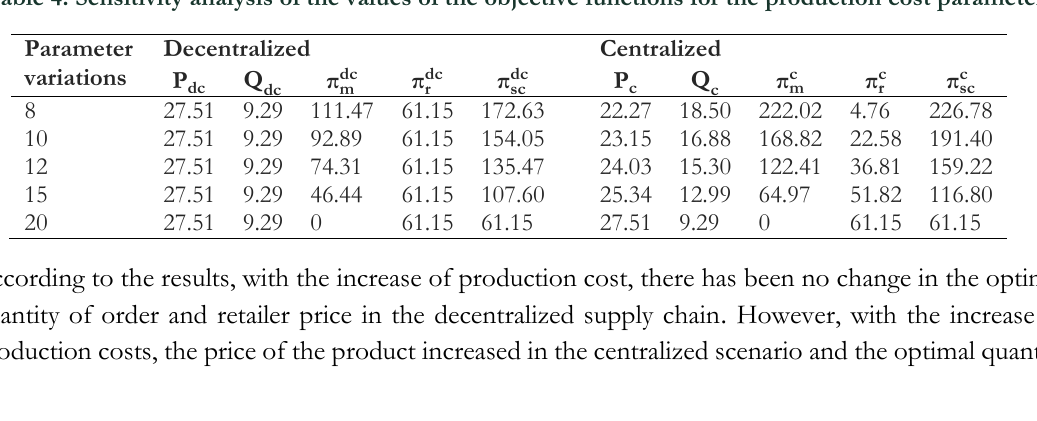
Table 4. Sensitivity analysis of the values of the objective functions for the production cost